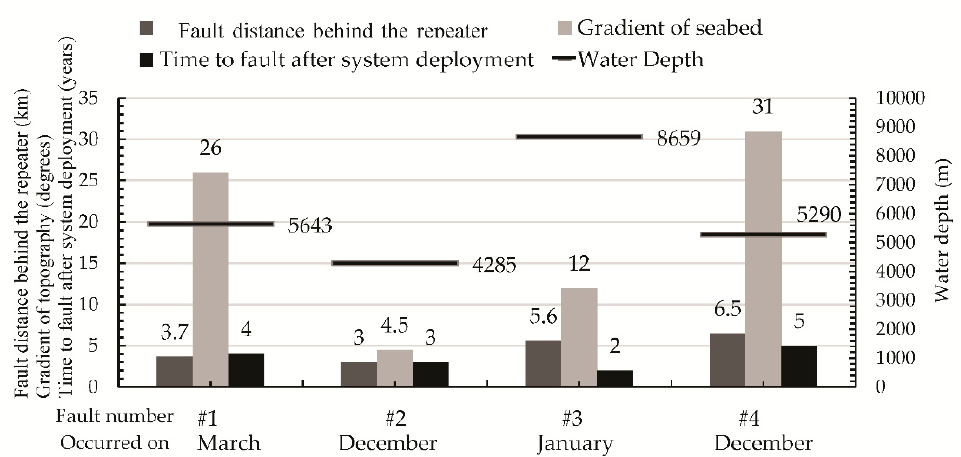
Figure 17. Individual situation of cable faults related to laying repeaters in LW cable.